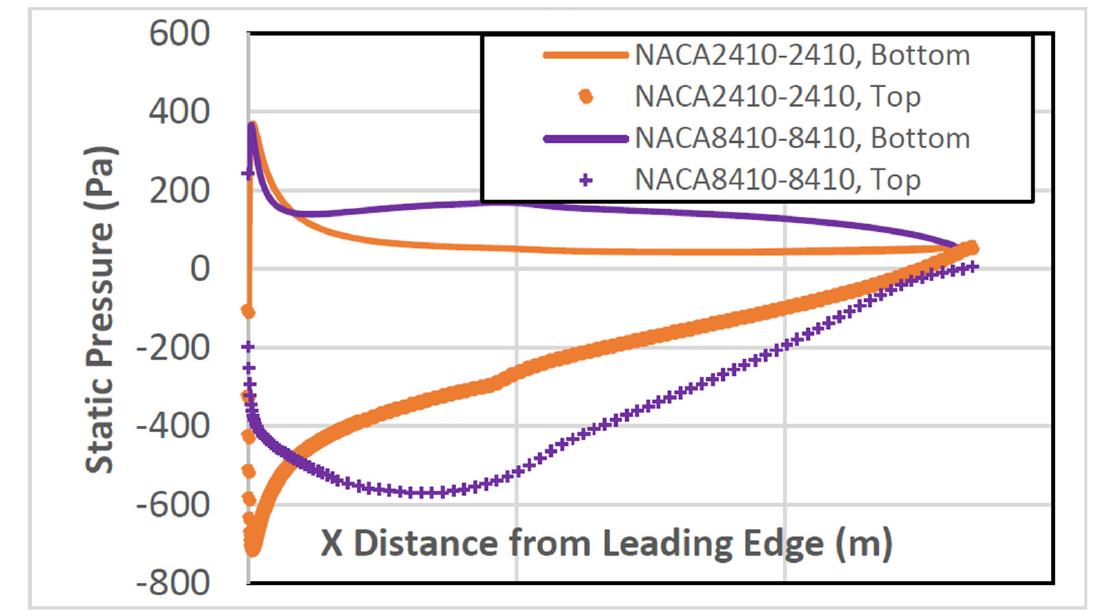
Figure 14. Turbulent kinetic energy contour of NACA8410 simulation with AoA ( a ) 1° and ( b ) 8°. For a more direct and precise comparison, the pressure distribution plots around NACA2410 and NACA8410 airfoils are presented in Figure 15. The pressure difference between the top and the bottom surface of the NACA8410 shown in purple is more sig- nificant than the pressure differences of the NACA2410 in orange. That correlates to higher 𝐶 and 𝐶 for NACA8410 than for NACA2410. (cid:3005) (cid:3013)